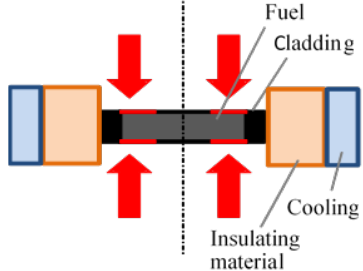
Fig. 1. Concept of laser simulated RIA conditions (The axis shows the axial symetry)